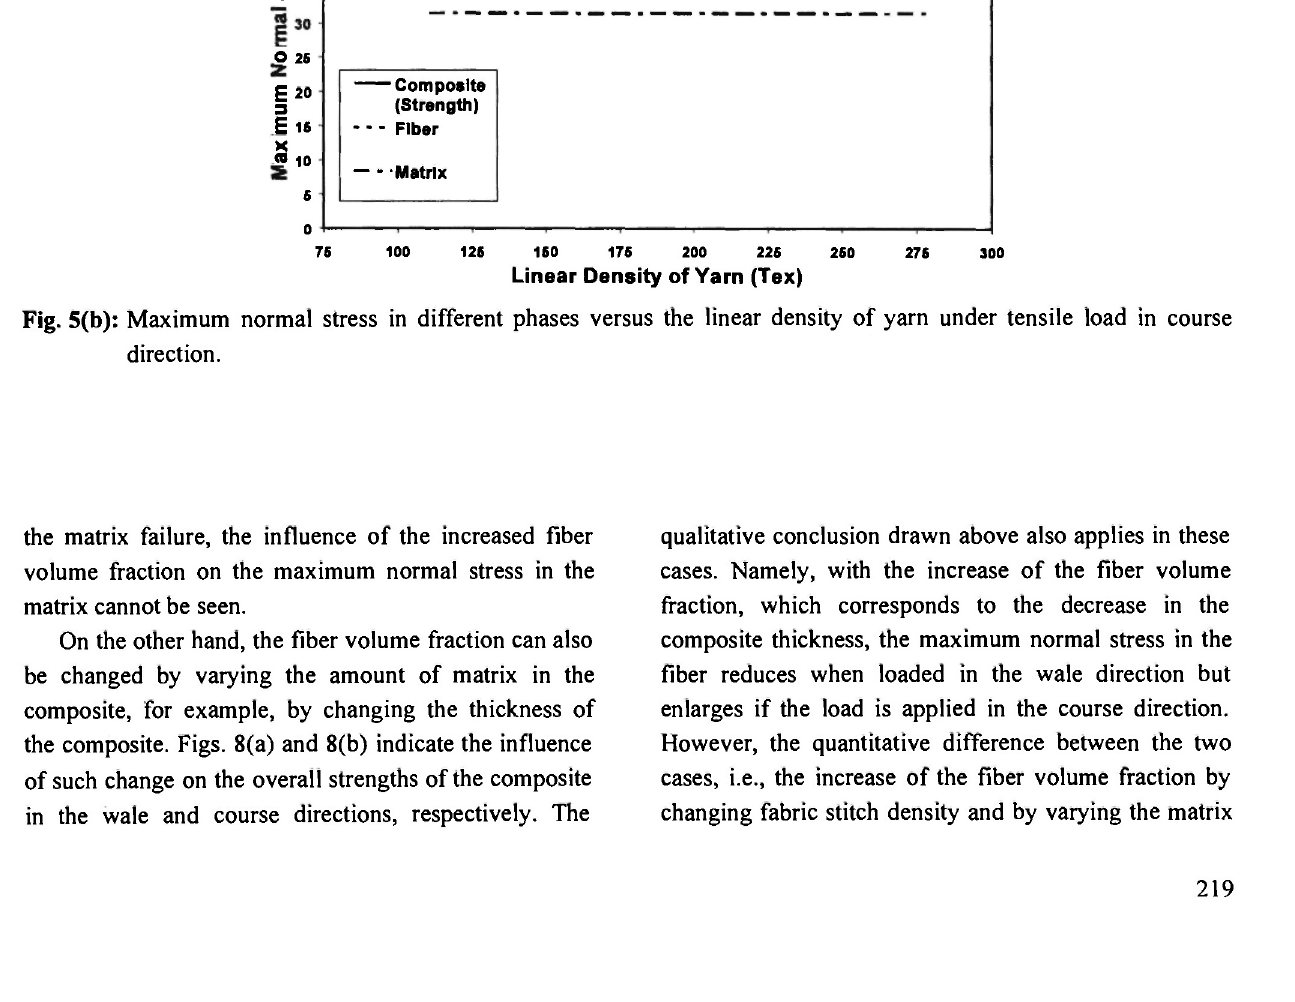
Fig. 5(b): Maximum normal stress in different phases versus the linear density of yarn under tensile load in course